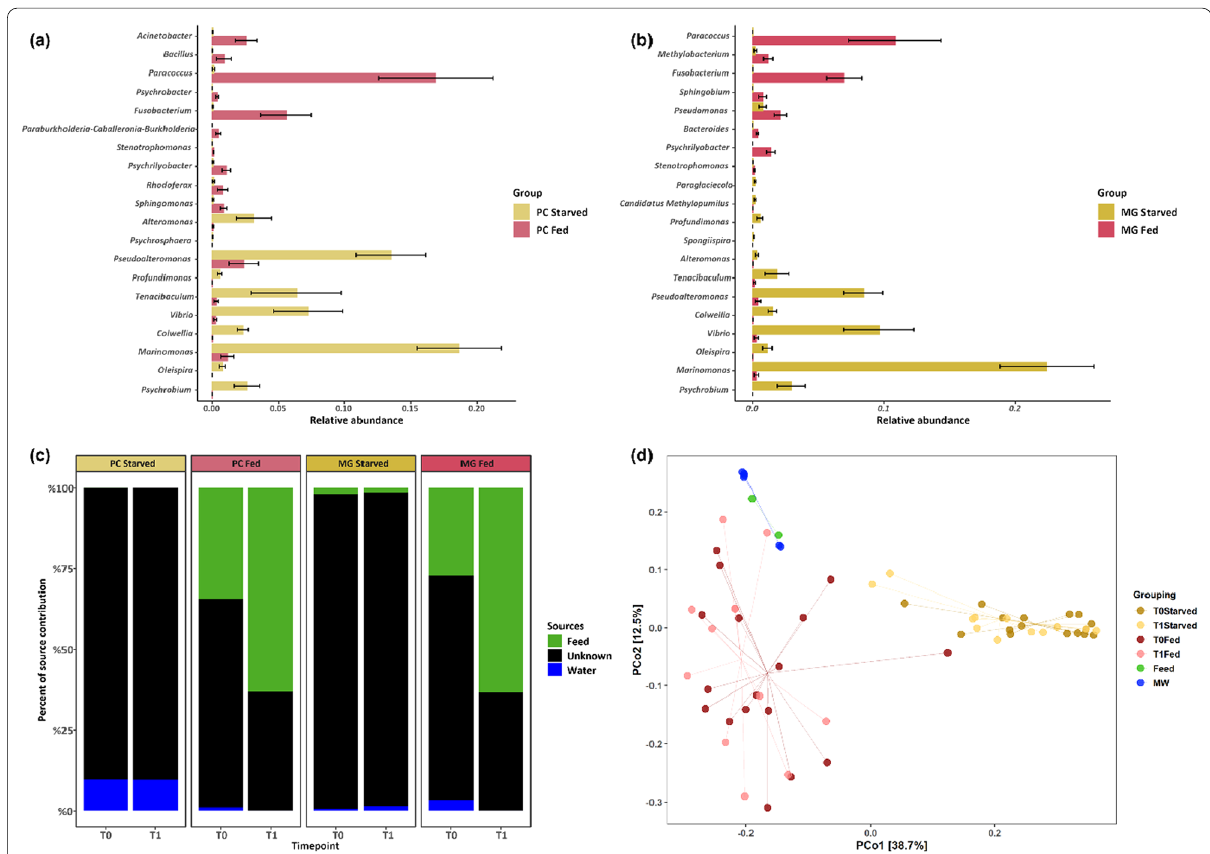
Fig. 5 Differential abundance analysis between starved and fed fish in PC samples ( a ) and MG samples ( b ). Important genera were determined with random forest classification. Mean decrease gini served as indicator value. c Shows the source tracking analysis determined by the FEAST framework. Bars show the average contribution of each source (either feed, water or unknown) to the overall microbial community for different gut compartments, feeding status and timepoints. d Illustrates a principal coordinates analysis (PCoA) derived from weighted UniFrac distances between environmental samples (MW Marine water and feed), starved fish ((48 h feed withdrawal) and recently fed fish at two different points in = time (T0 and T1). T1 was sampled 14 days after T0. Lines mark the position of the centroids of each group. For illustration purposes no differentiation between PC and MG samples was made. However, differentiation was included in Permanova calculations (Additional file 1: Tables S7,